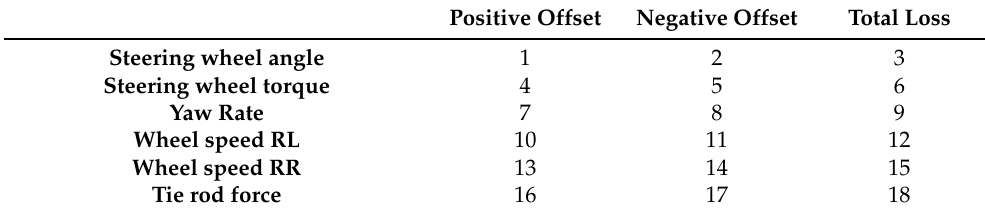
Table A1. Fault code for single sensor